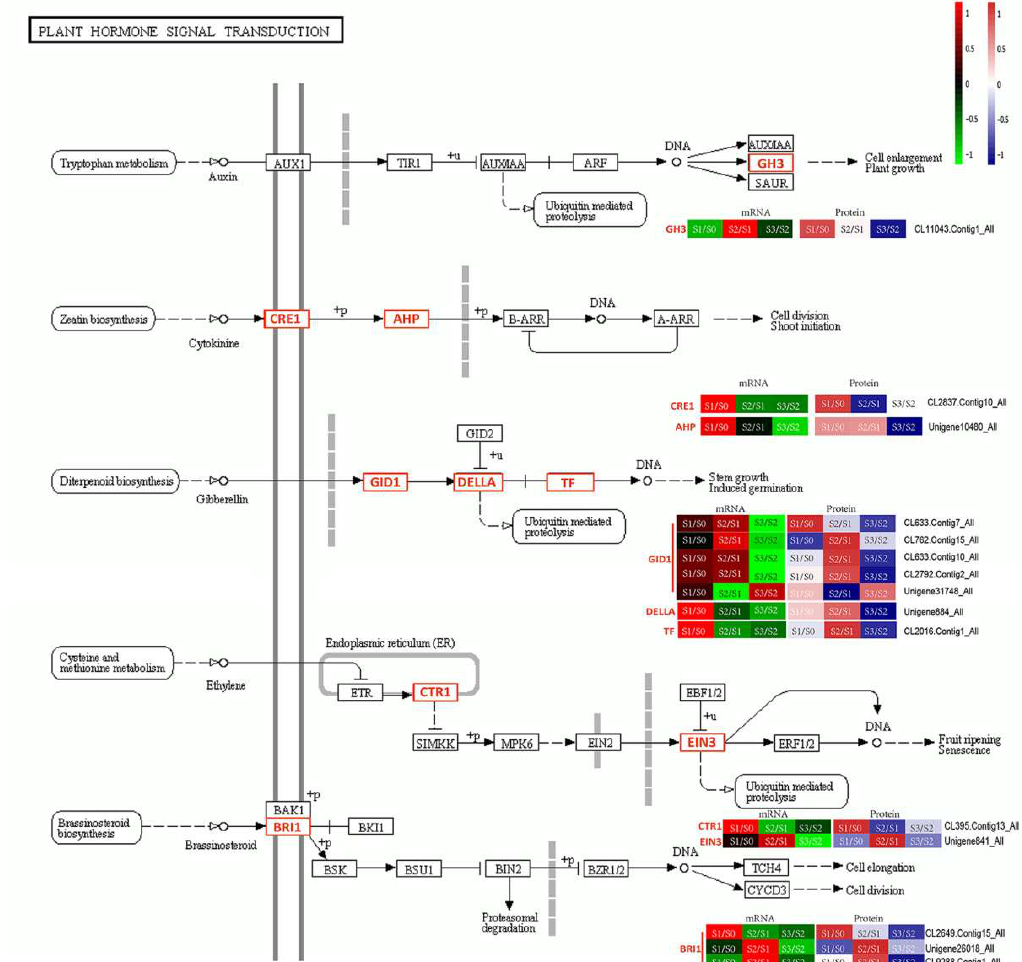
Figure 9. The key pathways during adventitious root formation. The relative changes in abundance (S1/S0, S2/S1 and S3/S2) are shown using a log2 scale. Double lines, cytomembrane; Grey wide dotted line, nuclear membrane; Grey wide line, endoplasmic reticulum membrane; +u, ubiquitination; +p,